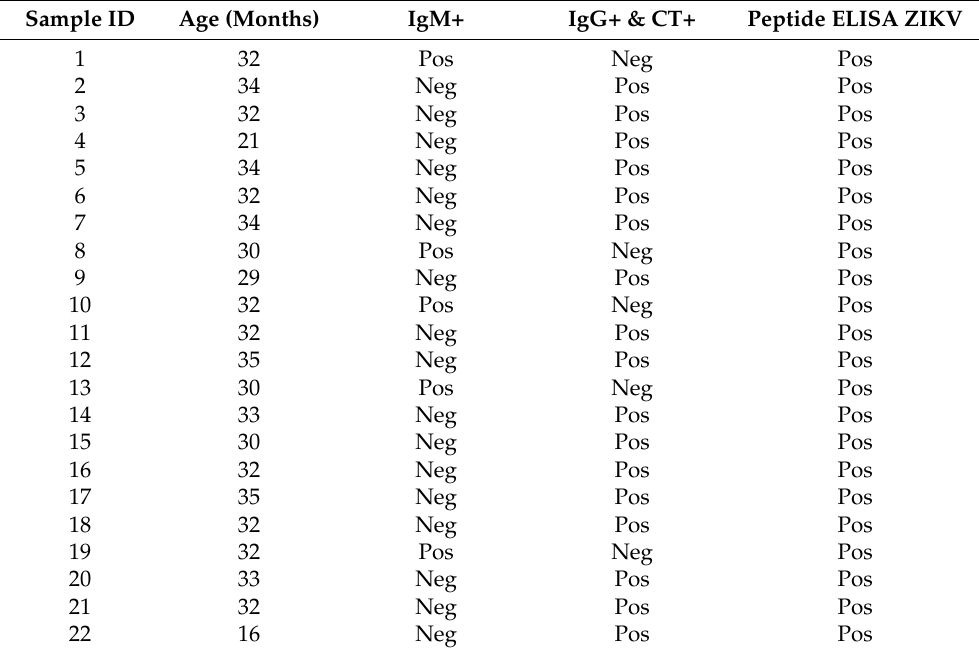
Table 5. ZIKV seroprevalence in Brazilian pediatric patients.